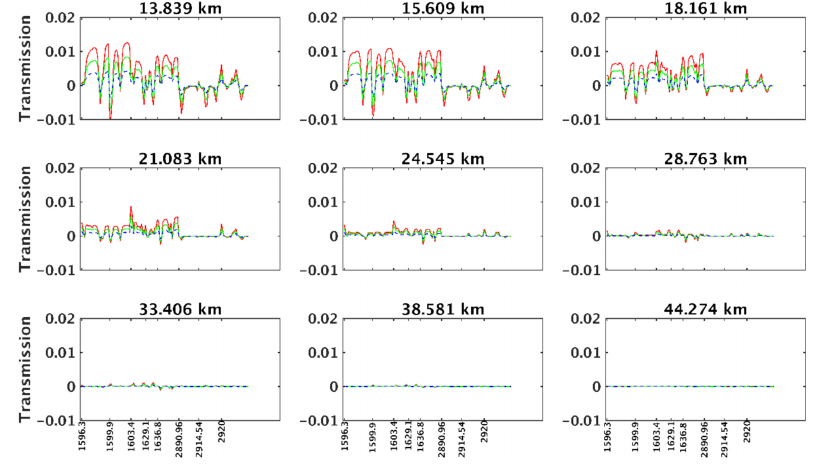
Figure 6. Curves of transmission variation caused by temperature plus 1 K (blue curve), 2 K (green curve), and 3 K (red curve) at different tangent heights.